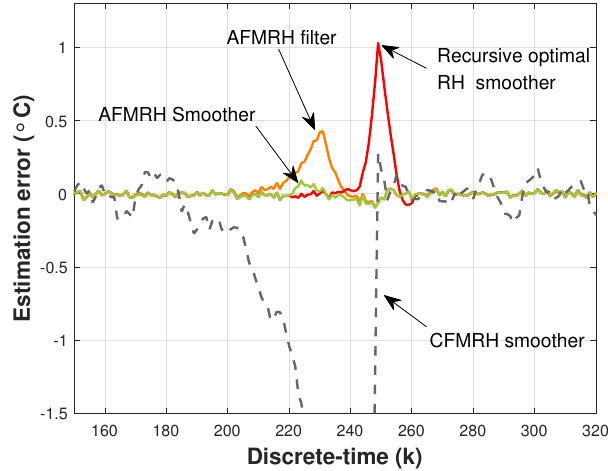
Figure 7. Estimation errors of